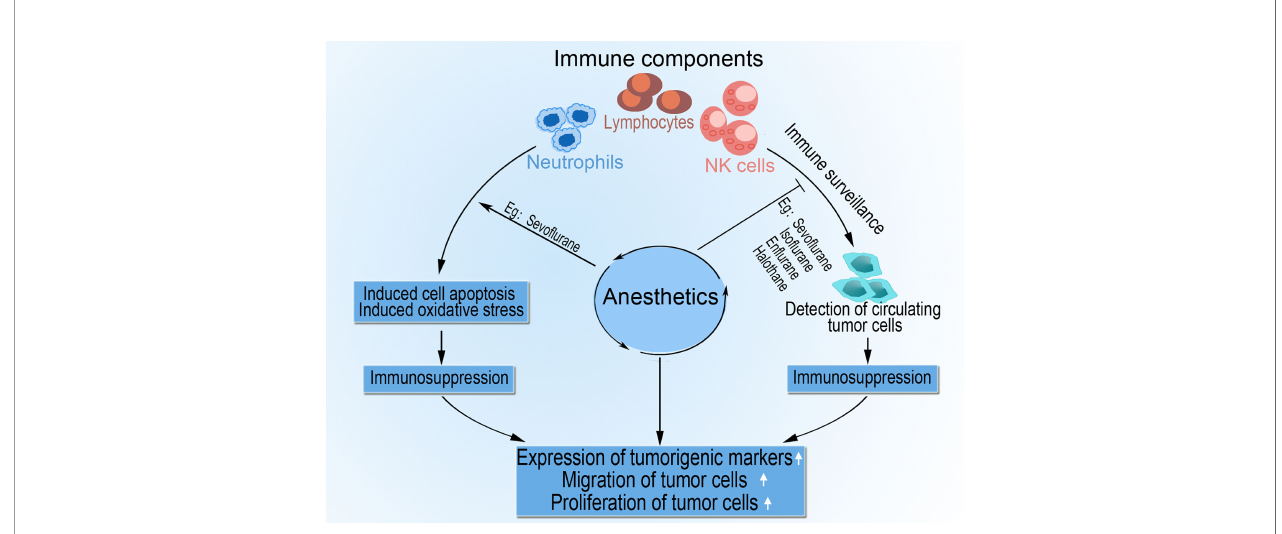
FIGURE 2 | The role of anesthesia in tumor progression. Anesthetic agents impair cell-mediated immunity by direct or indirect inhibition of components such as NK cells, lymphocytes, and neutrophils. Anesthesia also impedes immune surveillance of circulating tumor cells by NK cells and activates apoptosis and oxidative stress in lymphocytes and neutrophils. The resultant immunosuppression encourages tumor cell migration, proliferation, and upregulated expression of tumorigenic